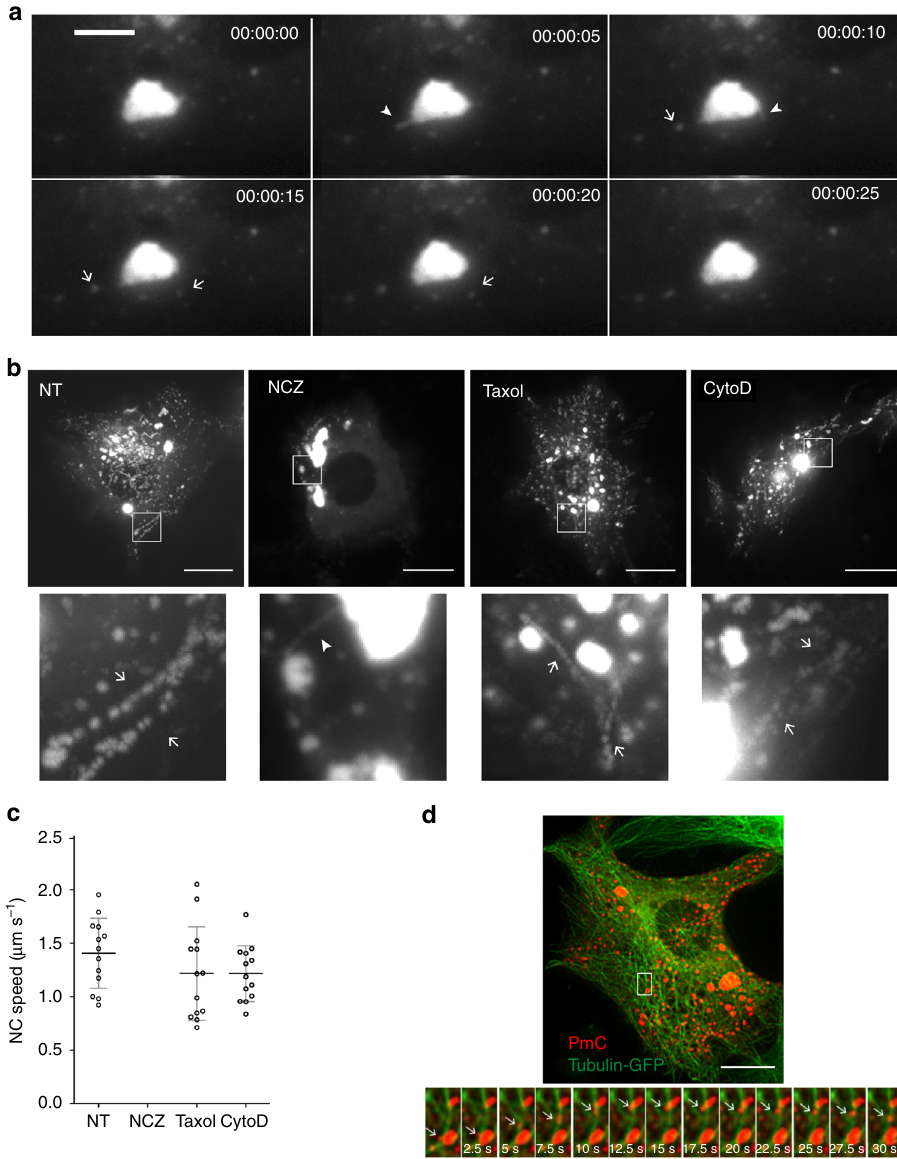
Fig. 5 RNPs are ejected from NBs and transported along the microtubule network. Live cell imaging was performed on BSR cells infected by rCVSN2C-P- mCherry at a MOI of 0.5 at 16 h p.i. a Ejection of RNPs from NBs. The time is indicated in the upper right corner . Images have been extracted from Supplementary Movie 6 and are shown at 5-sec intervals. Ejection events are observed on a single image and indicated by arrowheads. The resulting RNPs are indicated by arrows. Scale bar corresponds to 3 µ m. b Impact of cytoskeleton-disrupting drugs on RNPs transport in the cytosol. Nocodazole (NCZ, 2 µ M), Taxol (1.25 nM) and Cytochalasin D (Cyto D, 2.5 µ M) were added 1 h before and kept all along infection (NT: non-treated cells). 120 frames (one frame per 1 s, re fl ecting 120 s) of time-lapse microscopy (such as Supplementary Movie 7) are displayed as maximal intensity projection in order to visualize RNP trajectories which are indicated by arrows in the magni fi cation shown in the lower row. In the NCZ-treated cell (Supplementary Movie 8), an ejection event is indicated by an arrowhead showing that RNP ejection from NBs occurs in absence of an intact microtubule network. Scale bars correspond to 15 µ m. c Velocity of RNPs in the cytosol in non-treated and treated cells. The speed and the trajectories of RNPs were determined as described in the experimental procedures. Only the RNPs that were tracked on four consecutives images were taken into account. The mean is shown with error bars representing the SD. d RNPs are transported along microtubules. BSR cells were co-infected with rCVS N2C-P-mCherry and a modi fi ed baculovirus encoding human tubulin-GFP (Cell-light Tubulin-GFP). Images were deconvoluated using the Huygens Imaging software (Supplementary Fig. 5). Scale bar corresponds to 15 µ m. Images have been extracted from Supplementary Movie 9 and are shown at 2.5-s intervals ( bottom row immunized with puri fi ed nucleocapsids. Both were used at a 1/1000 dilution. Anti- Medicine, Houston, TX 77584, USA). The plasmid pFAK-GFP encoding FAK in HSP70 MAb (SPA-810) (1/200 dilution) was obtained from Stressgen. Nocodazole fusion with GFP has been described previously 19 . (M1404), Taxol (Paclitaxel T1402), Cytochalasin, D (30385), were purchased from pTit-P-mCherry plasmid encoding the P protein of CVS C-terminally fused to Sigma. the mCherry fl uorescent protein has been constructed using Gibson assembly kit (New England Biolabs). The P gene fused to the mCherry has been PCR ampli fi ed from the full-length genomic plasmid prN2C-P-mCherry 20 . Plasmids pTit-P Δ , encoding truncated forms of P protein, have been Plasmids . The plasmid encoding G3BP-EGFP 52 was kindly provided by Dr R constructed using Gibson assembly kit. PCR products encoding fragments of the Lloyd (Department of Molecular Virology and Microbiology, Baylor College of